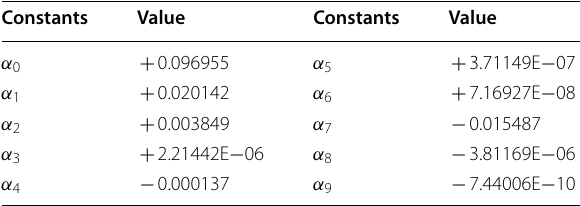
Table 12 Constants in the suggested Eq.